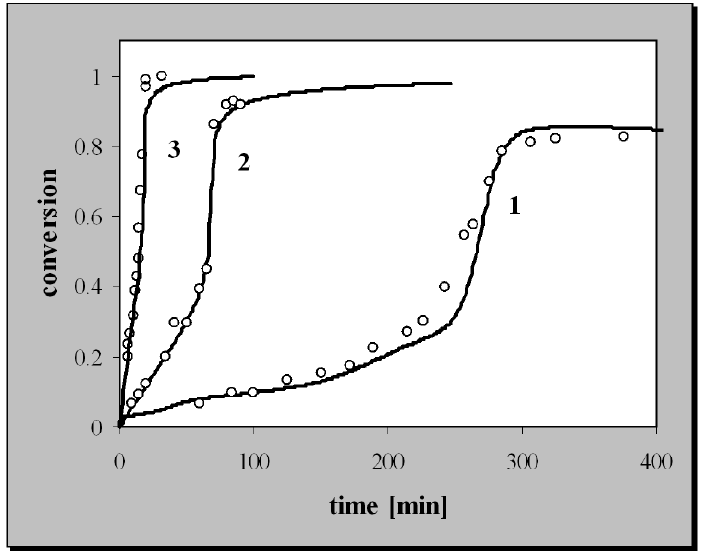
Fig. 5 Variation of monomer conversion with time for: (1) T = 50 o C and I 0 = 20.18 mol/m 3 ; (2) T = 70 o C and I 0 = 15.48 mol/m 3 ; (3) T = 90 o C and I 0 = 25.8 mol/m 3 ; o { experimental data [15,16]; solid lines { predictions of MLP (3:9:3:1) on validation data